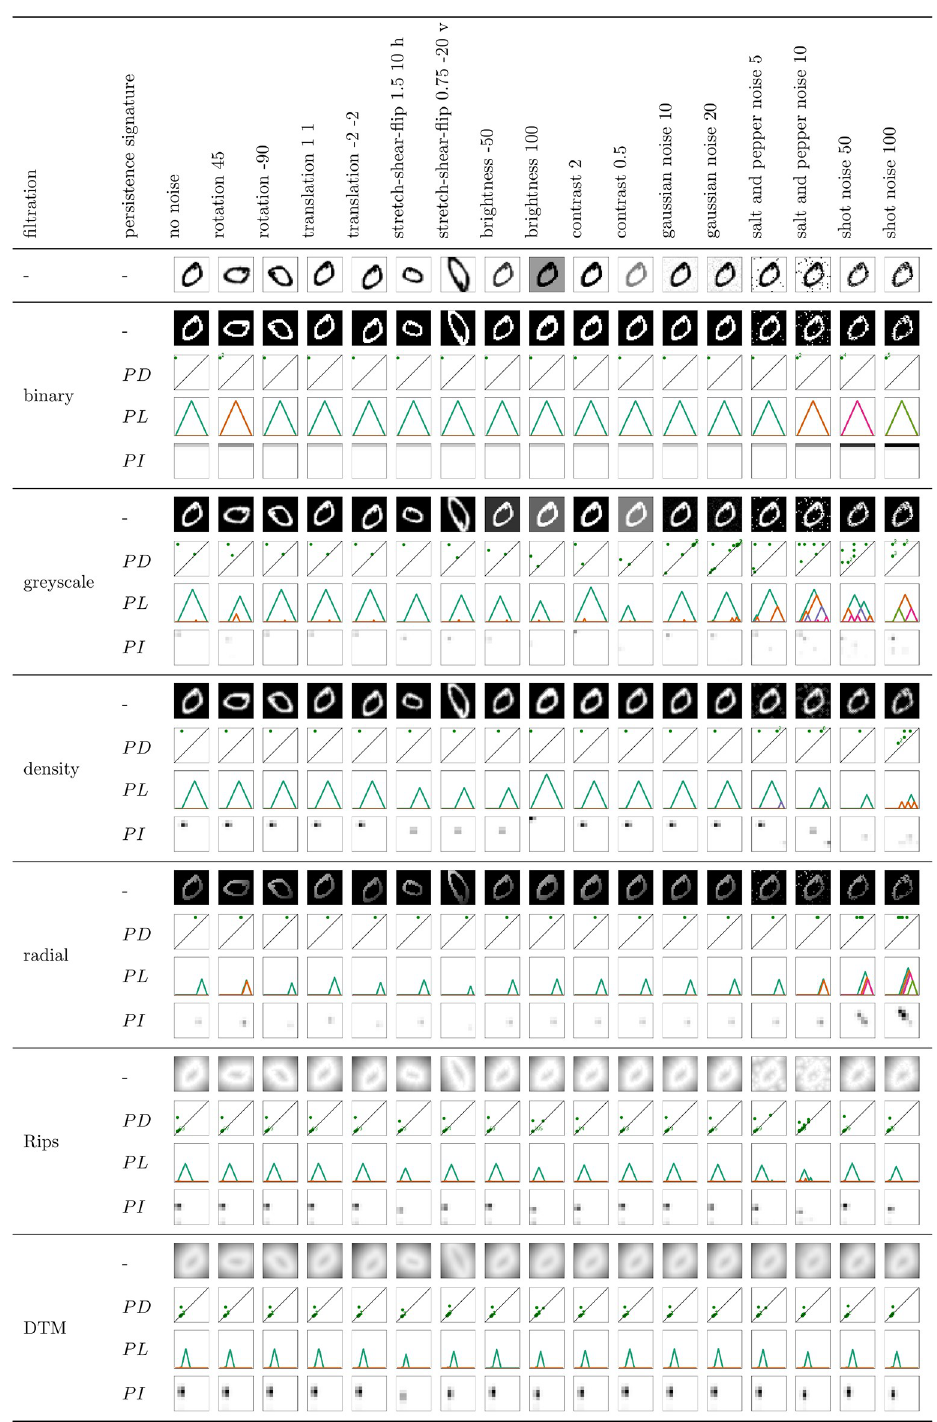
Fig 6. Noise robustness of 1-dimensional persistent homology on an example image. Illustration of the effect of various image transformations when the image is represented with its filtration function values (1st row of each filtration), or 1-dimensional persistence diagram (2nd row), persistence landscape (3rd row), or persistence image (4th row).